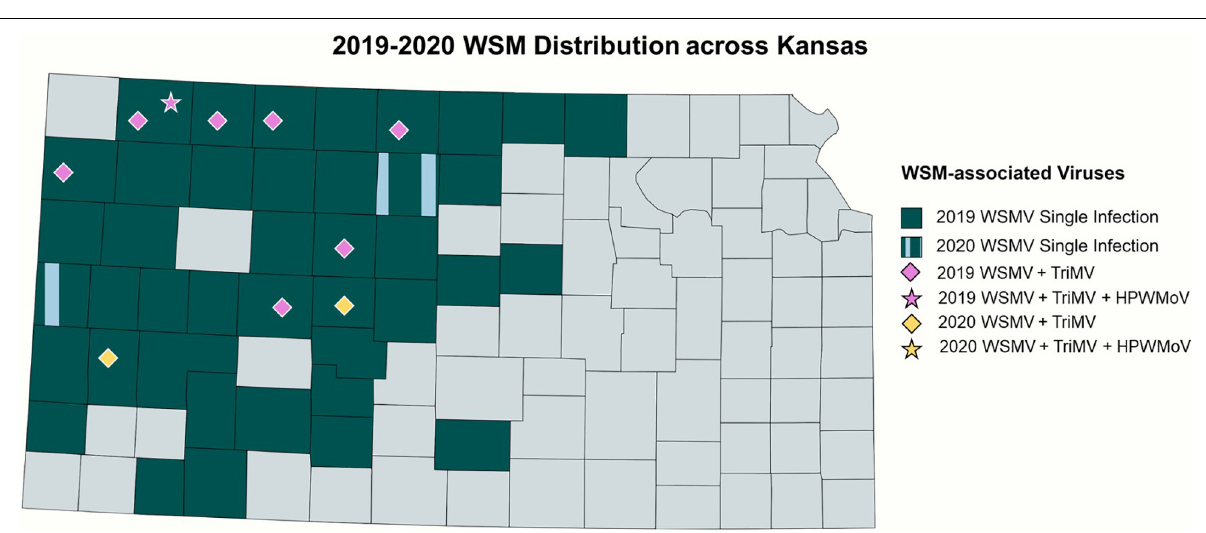
FIGURE 3 | Distribution of WSM-associated viruses in Kansas. 2019 single infections of WSMV is highlighted in dark blue, and single infections of WSMV in both 2019 and 2020 were highlighted with vertical patterns of light blue. The mixed infections of WSMV + TriMV are depicted by the diamonds, and the mixed infection of WSMV + TriMV + HPWMoV is shown in the star, with the purple color depicting the 2019 isolates and yellow for